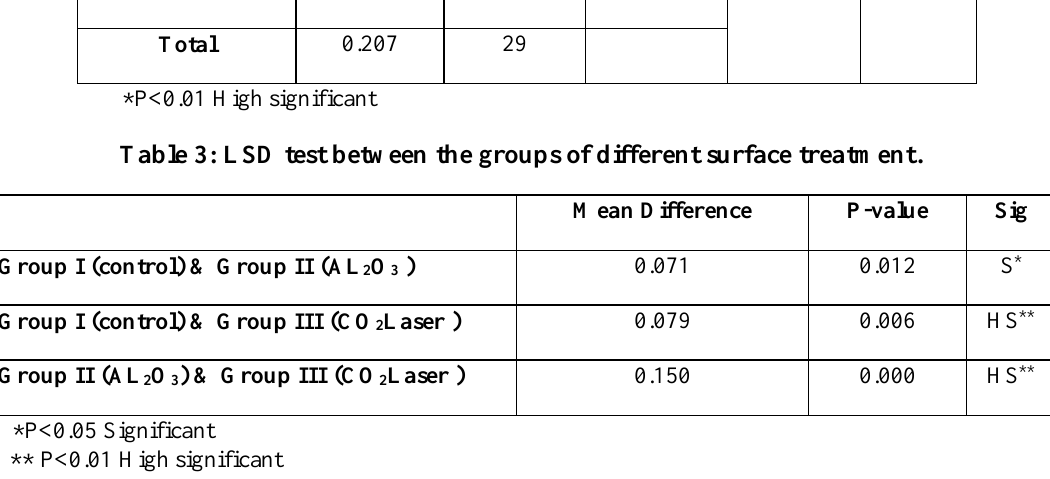
Table 2: ANOVA of shear bond strength between groups of the soft liner according to different surface treatment. Sum of Mean DF F-test P-value Squares Square Between groups 0.113 2 0.056 16.136 0.000 Within Groups 0.094 27 0.003